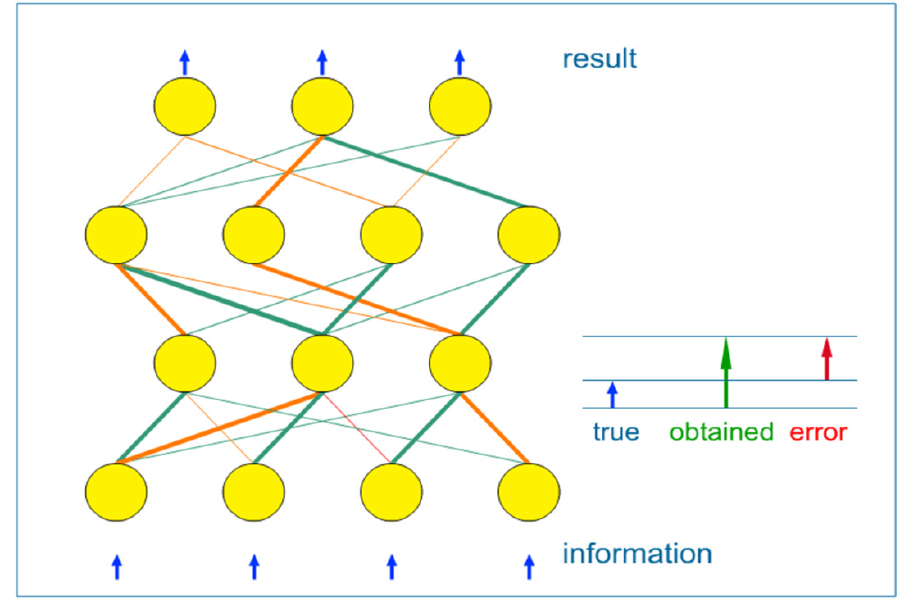
Figure 3. Schematic representation of feed-forward neural